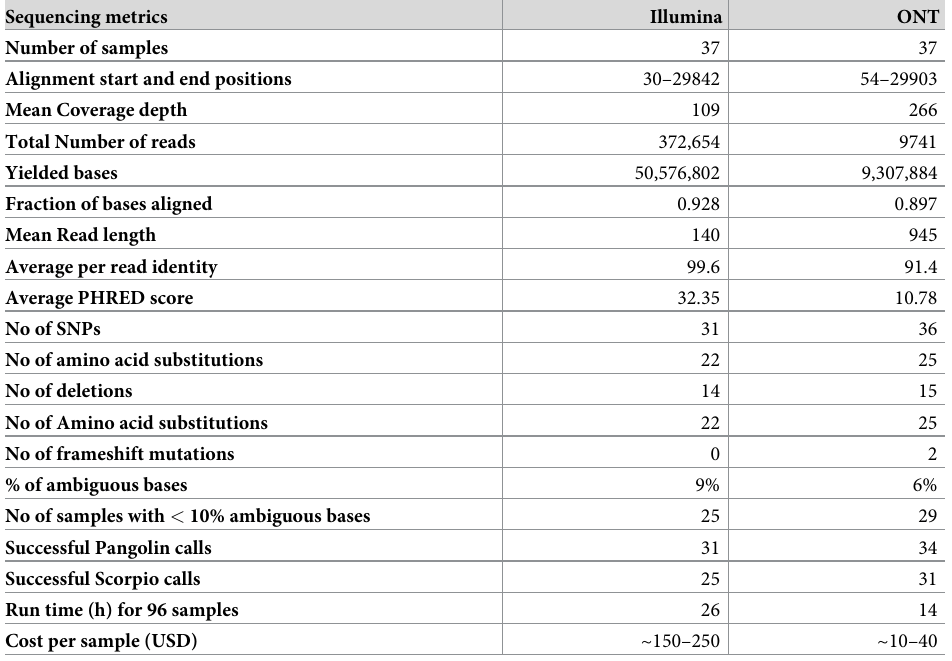
Table 1. Basic sequencing matrices for Illumina and Oxford Nanopore (ONT) outputs of 37. Sequencing